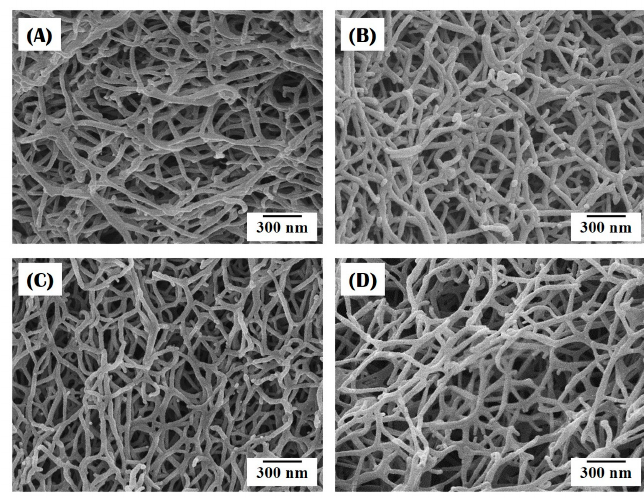
Figure 3. Representative FE-SEM images of the nanofibrous structure of nanofibrous collagen/HA composite microspheres synthesized with different levels of HA: ( A ) 0 wt %; ( B ) 10 wt %; ( C ) 15 wt %; ( D ) 20 wt %.